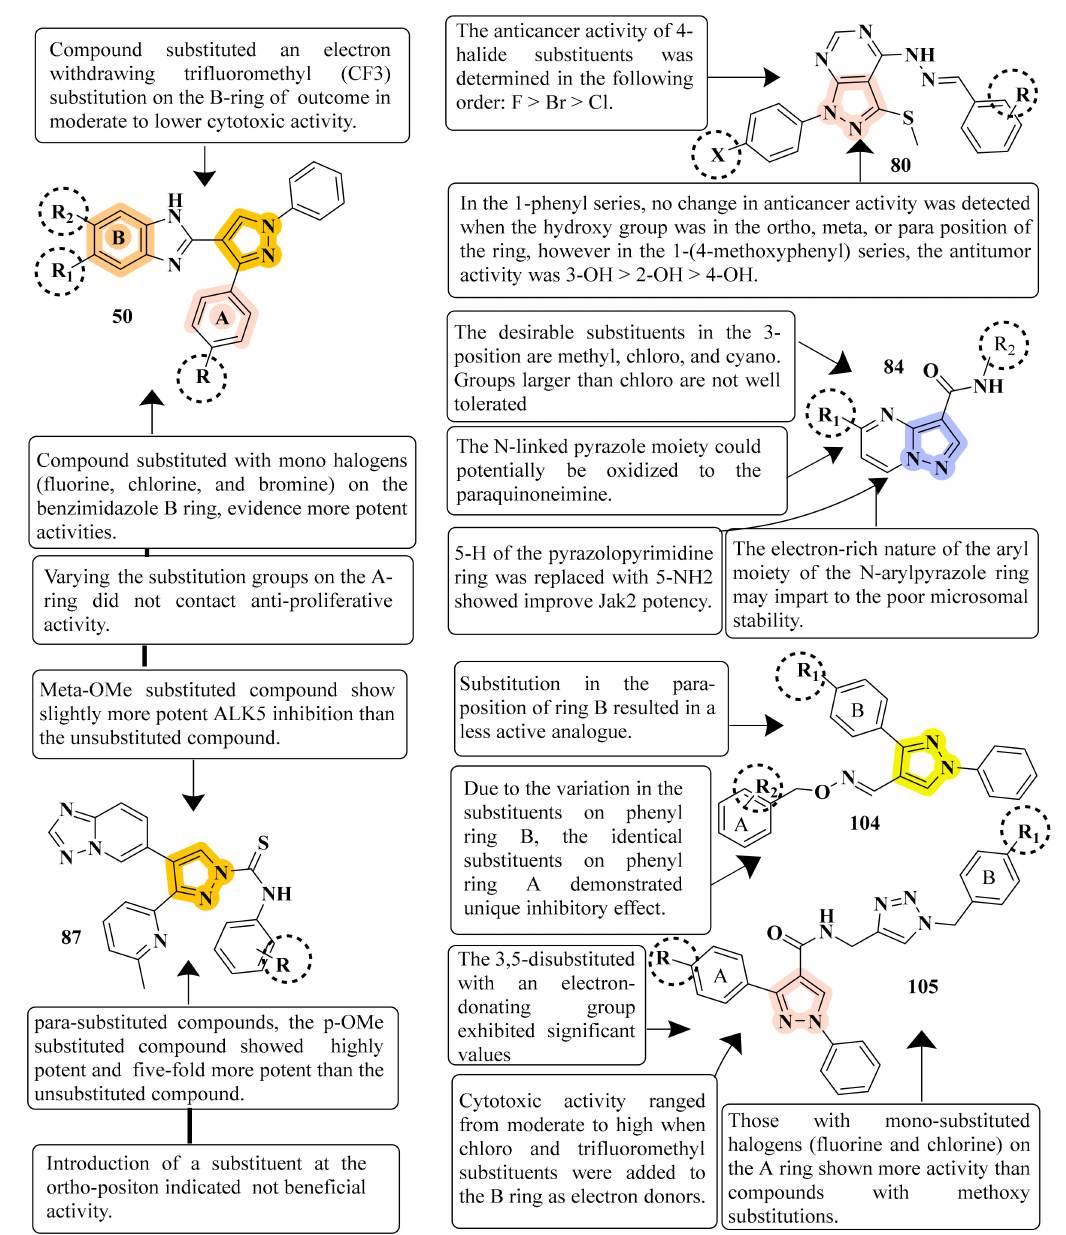
Figure 5. Structure and SAR of potent anticancer activity compounds 50 , 80 , 87 , 104 , and 105 . Several of the pyridyl-substituted five-membered heterocyclic rings were boosted in their inhibitory activity and selectivity by adding methylene, methylene amino, or amino methylene linkages between their core rings and their phenyl rings. The most active compound 87 inhibited ALK5 phosphorylation with a IC 50 value of 0.57 nM and demonstrated 94 percent inhibition at 100 nM in a luciferase reporter test using HaCaT cells irreversibly transfected with a p3TP-Luc construct. There was a significant increase in both the inhibitory activity and selectivity of compound 87 against p38a MAP kinase upon the incorporation of the [1,2,4]triazolo[1,5-a]pyridin-6-yl and phenycarbothioamide moiety at positions 4 and 1 of the pyrazole ring, respectively [101] (refer to Figure 5 for Structure and SAR).This work demonstrated the strong immunosuppressive actions of a variety of new pyrazole derivatives having an O-benzyl oxime moiety. Compound 104 had the greatest inhibitory efficacy (IC 50 = 1.18 µ M for lymph node cells and IC 50 = 0.28 µ M for PI3K). In particular, a variety of synthesized pyrazole oxime ether analogs were